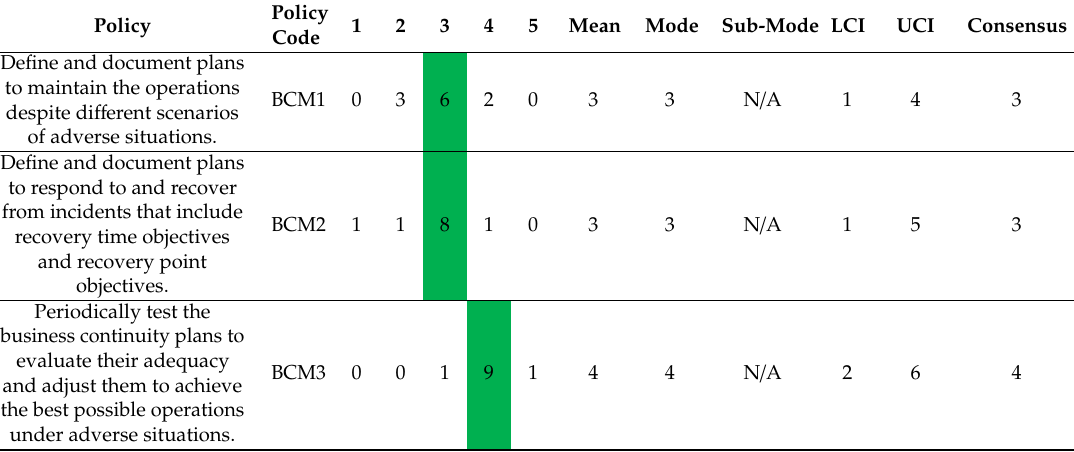
Table 26. Business continuity management policies’ starting